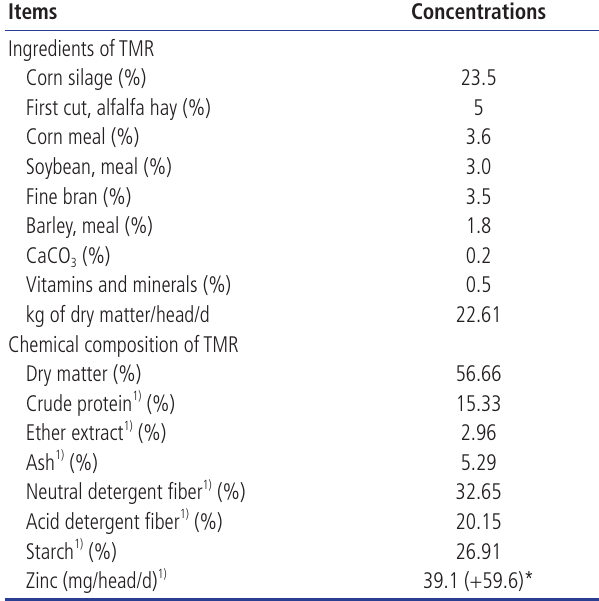
Table 1. Ingredients and composition of TMR administered to each cow of control and experimental